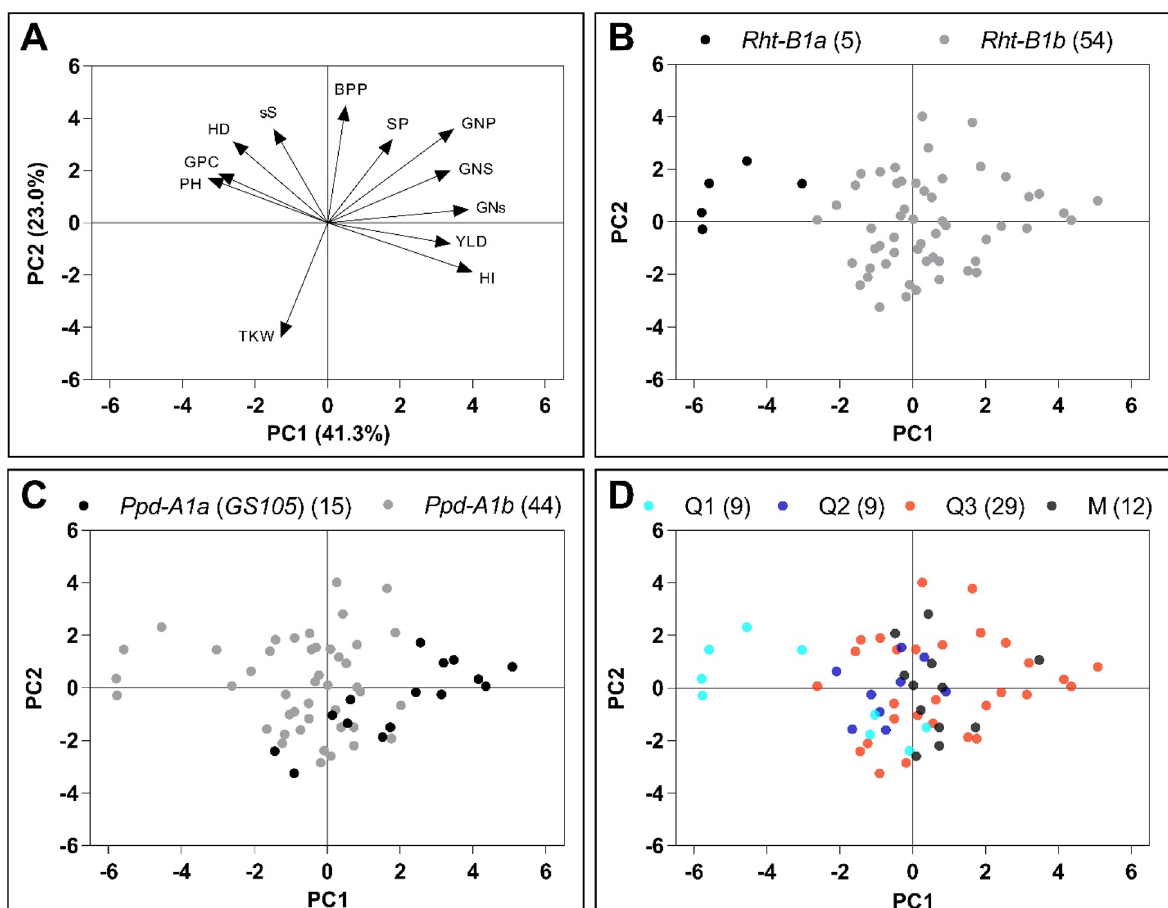
Figure 3. Principal components analysis (PCA) of agronomic traits for 59 Argentinian durum wheat genotypes. Traits correlation matrix is symbolized as vectors in A. Distribution of allelic variants at Rht-B1 and Ppd-A1 loci are shown in B and C, respectively. Colors represent the different groups from STRU CTU RE in D. YLD grain yield, HI harvest index, BPP aerial biomass, GPC grain protein content, PH plant height, HD heading date, TKW thousand kernel weight, GNP grain number per plant, GNS grain number per spike, GNs grain number per spikelet, sS spikelets per spike, SP spikes per plant.